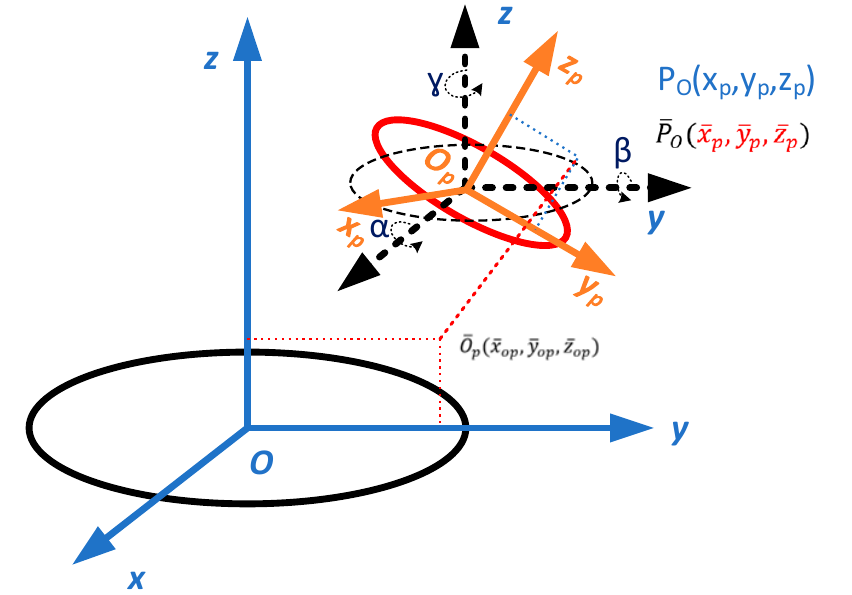
Figure 2. Coordinate transformation.